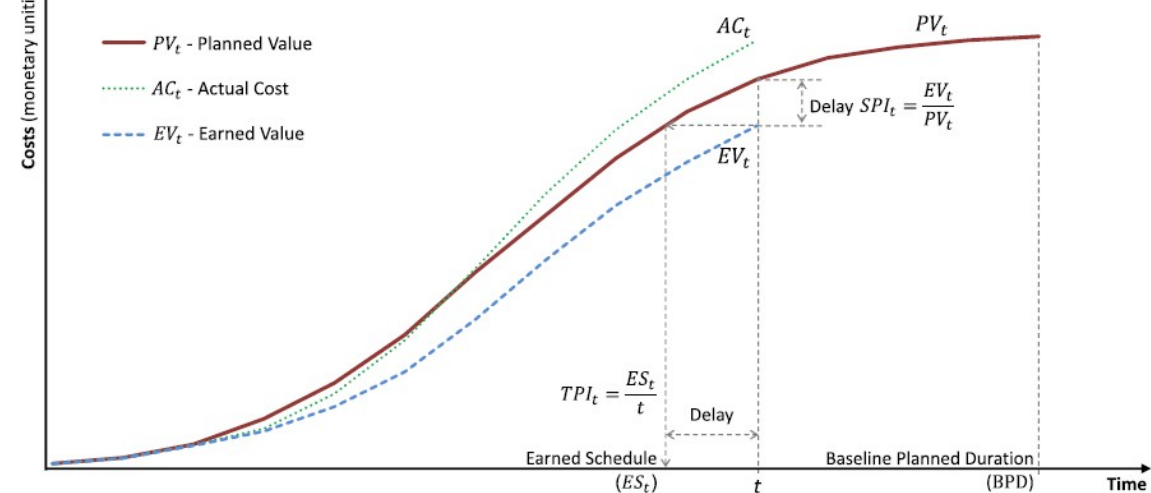
Figure 1. Earned value and earned schedule conceptual diagram. Reprinted with permission from ref. [22]. Coprright 1983 American Society of Civil Engineers.